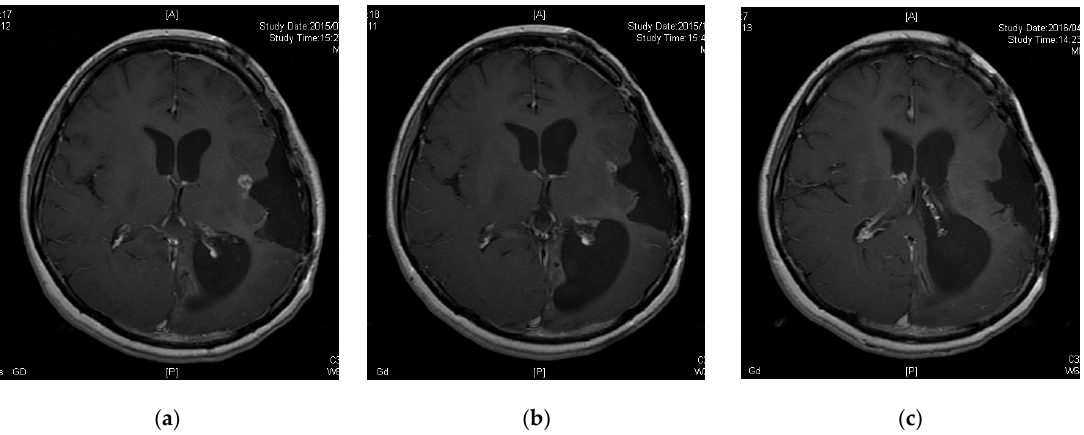
Figure 2. Contrast-enhanced magnetic resonance images of Patient 6. ( a ) Tumor had recurred in a functional area; ( b ) tumor was decreased 3 months after enrollment; ( c ) tumor disappeared 9 months after enrollment.